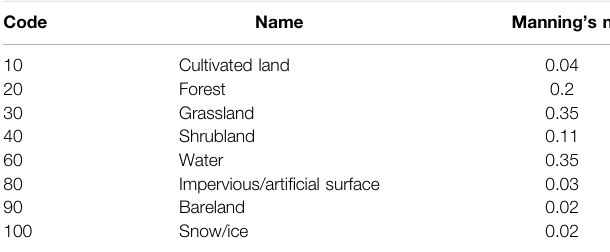
TABLE 2 | Code, name, Manning ’ s n of different land cover used in this study (Brunner, 2010). Code